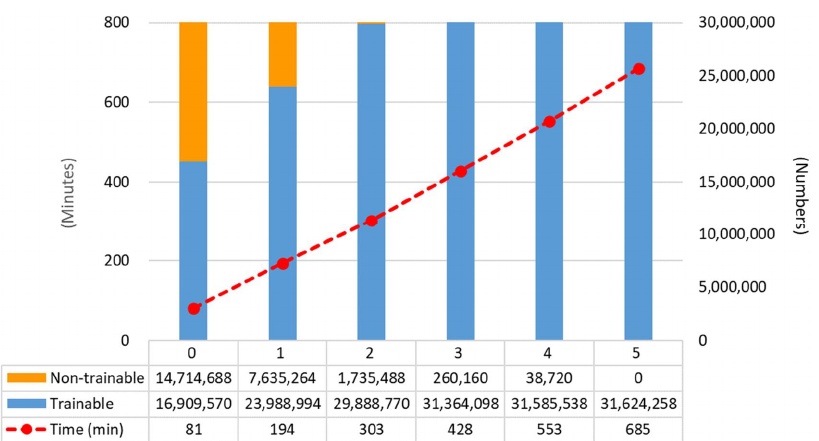
Figure 6. The number of trainable parameters (Trainable), the number of non-trainable parameters (Non-trainable) and the total training time (Time) of each experimental group in this study.